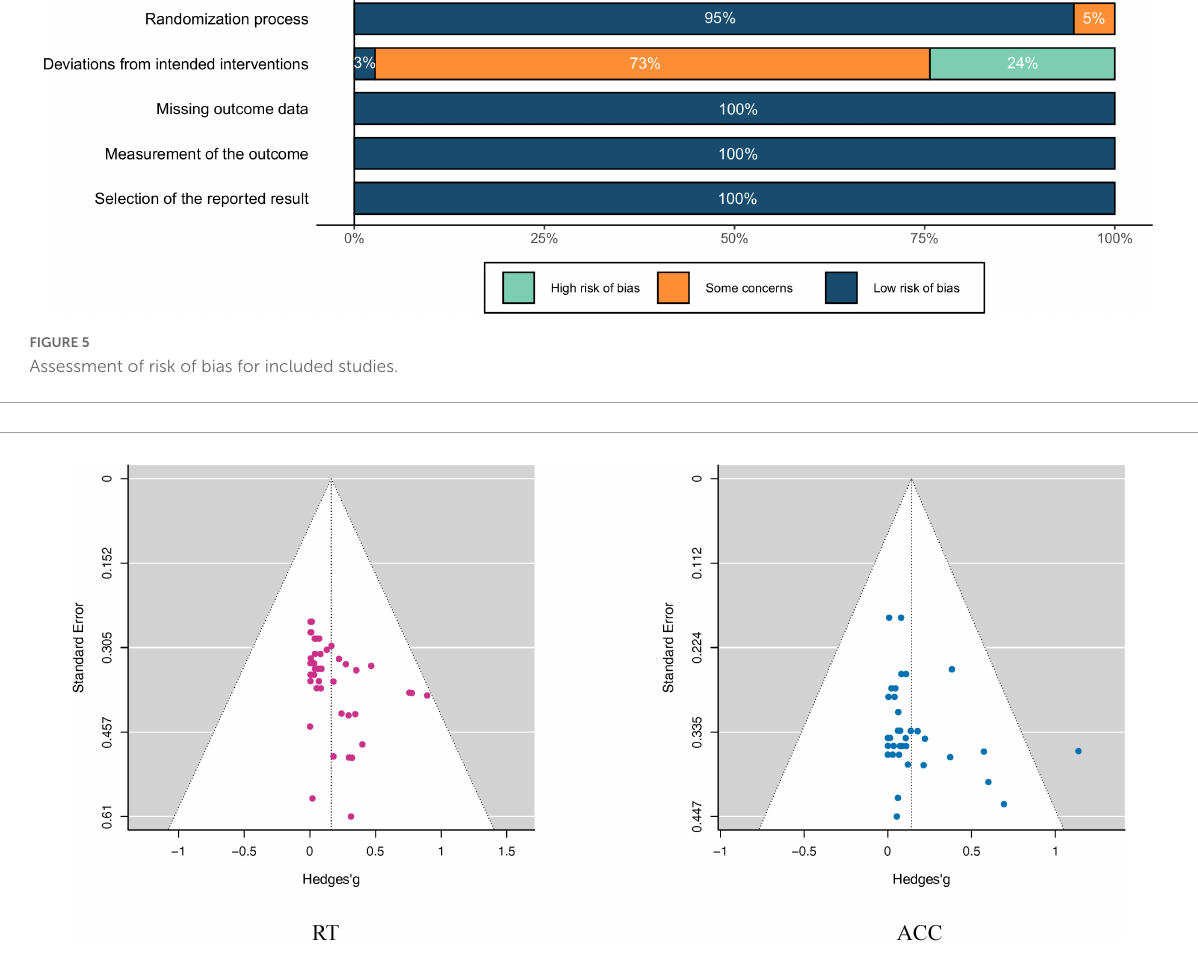
FIGURE6 Funnel plots assess publication bias in the RT and ACC outcomes. The Funnel plots took the Mean difference as the abscissa and Standard Error as the ordinate. The small dots in the figure represent the included studies. In the funnel plot, the dotted line perpendicular to the horizontal axis represents the overall effect, and the dotted line on both sides represents the 95% confidence interval (CI). As shown in this figure, the distribution of all studies in the funnel plot was roughly symmetric, suggesting that there was no publication bias. Although the funnel plot can visually observe publication bias, it is subjective, and it can be seen that individual studies deviate from 95% confidence interval (CI). Therefore, we adopted Egger’s test to quantify the publication bias. Note that the point outside the white area in the ACC funnel plot does not represent an outlier, because the significance of the further quantitative Egger Test was not affected by including or excluding this